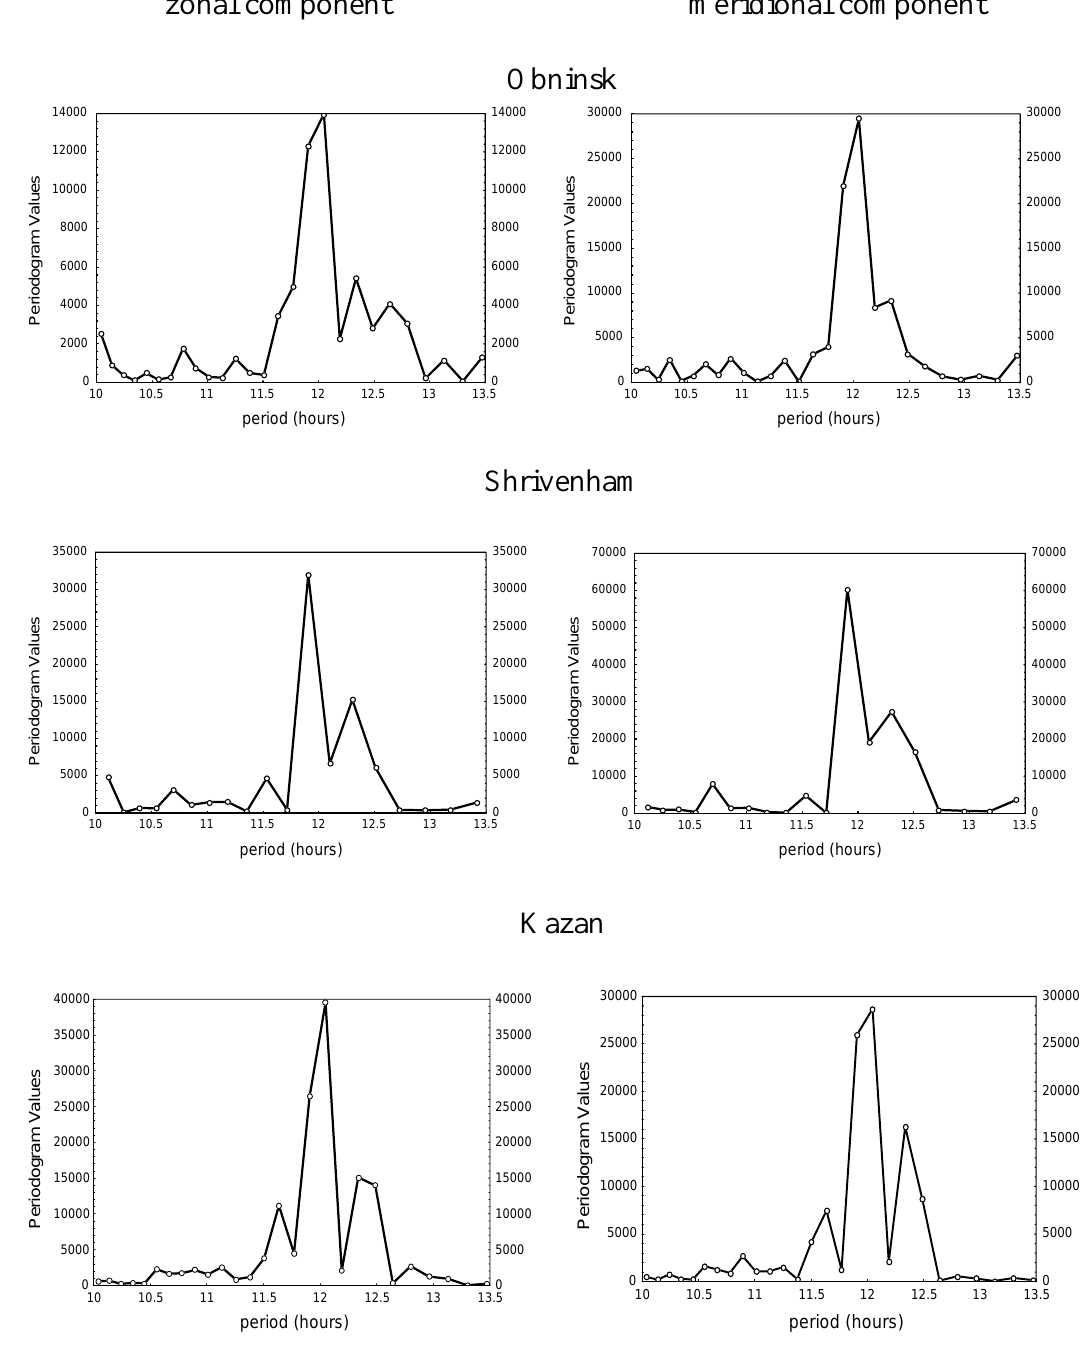
Fig. 12. Periodograms evaluated for the hourly wind data of the winter 1998 campaign.